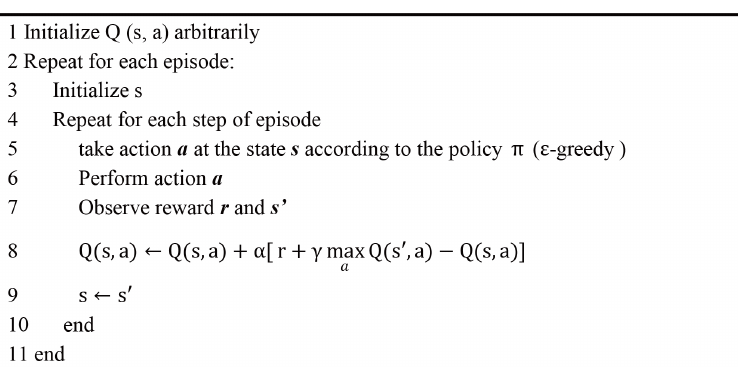
Figure 8. Basic architecture of RL.